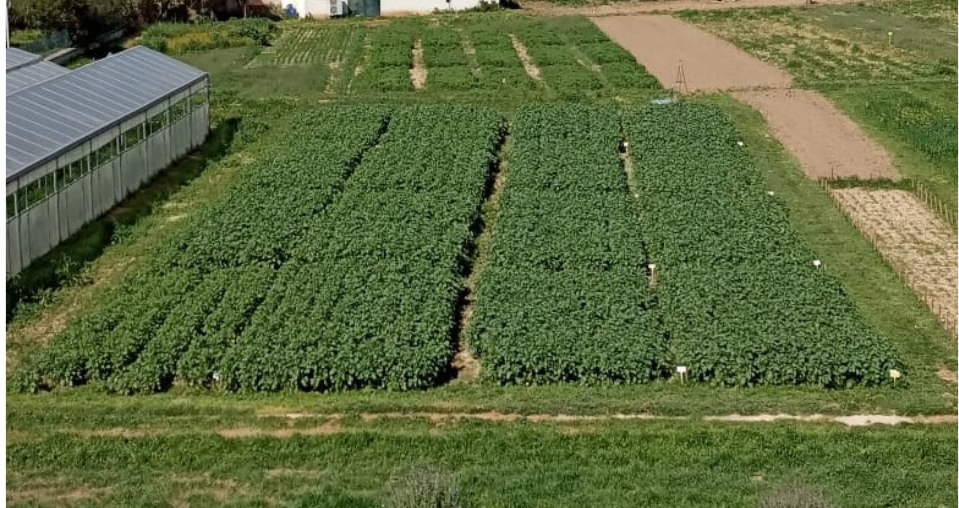
Figure 1. Overview of the black mustard experimental field taken from the southeast on 24 March 2021 (120 days after sowing).